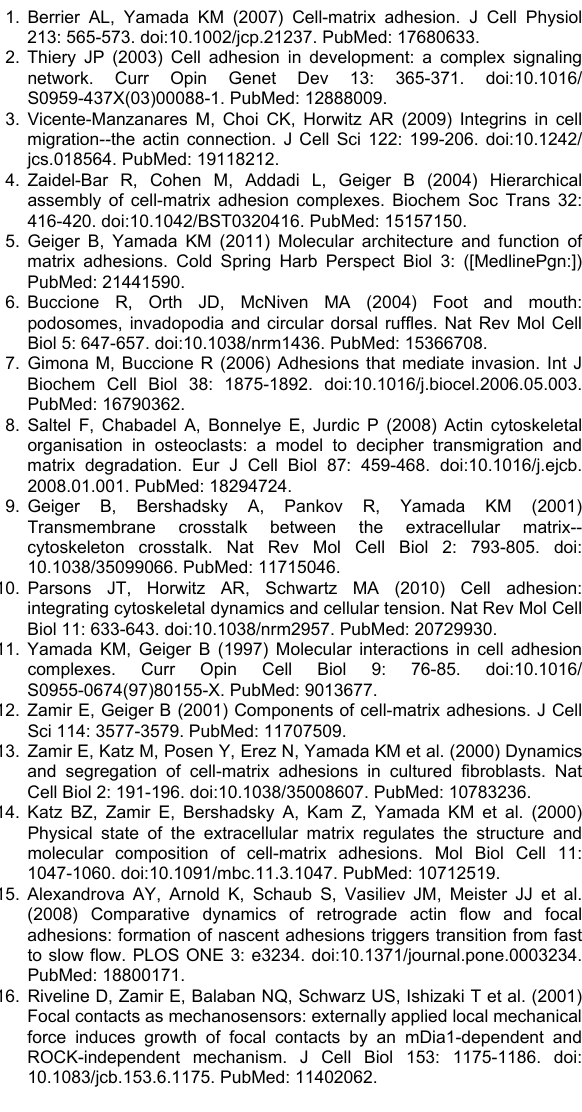
Figure S2. Effect of Y-27632 treatment on FA